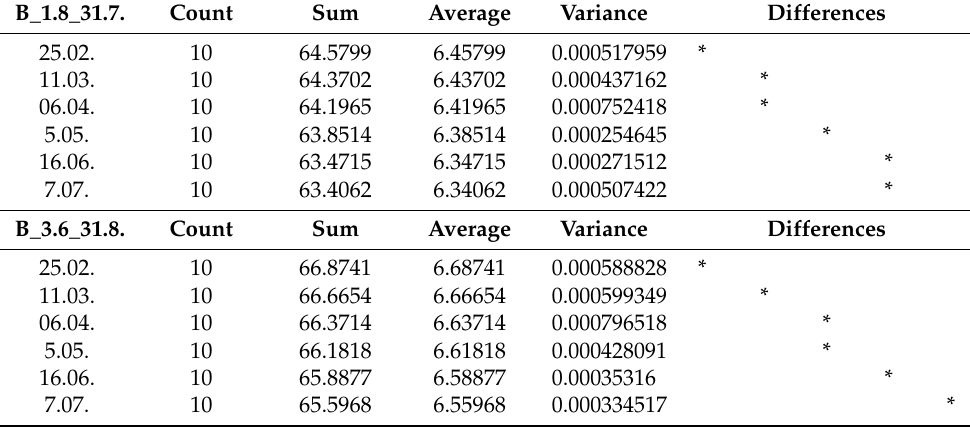
Table 4. Results of the ANOVA test for the tubes of producer B, the asterisks indicate which between- groups differences proved